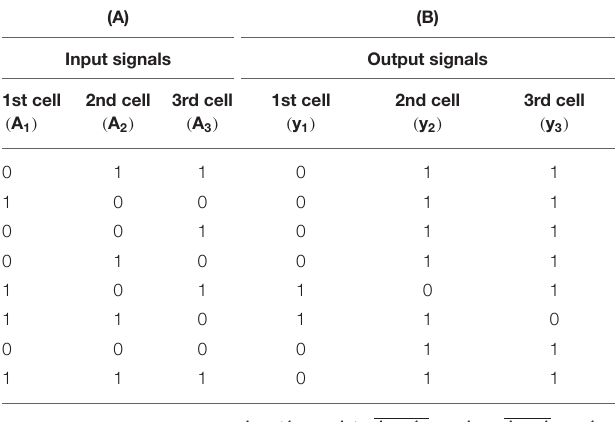
TABLE 2 | (A) Table of input signals valid for three coupled cells in cyclic array. (B) Truth table for the logic gate with knockout perturbation {0 1 1} (three coupled